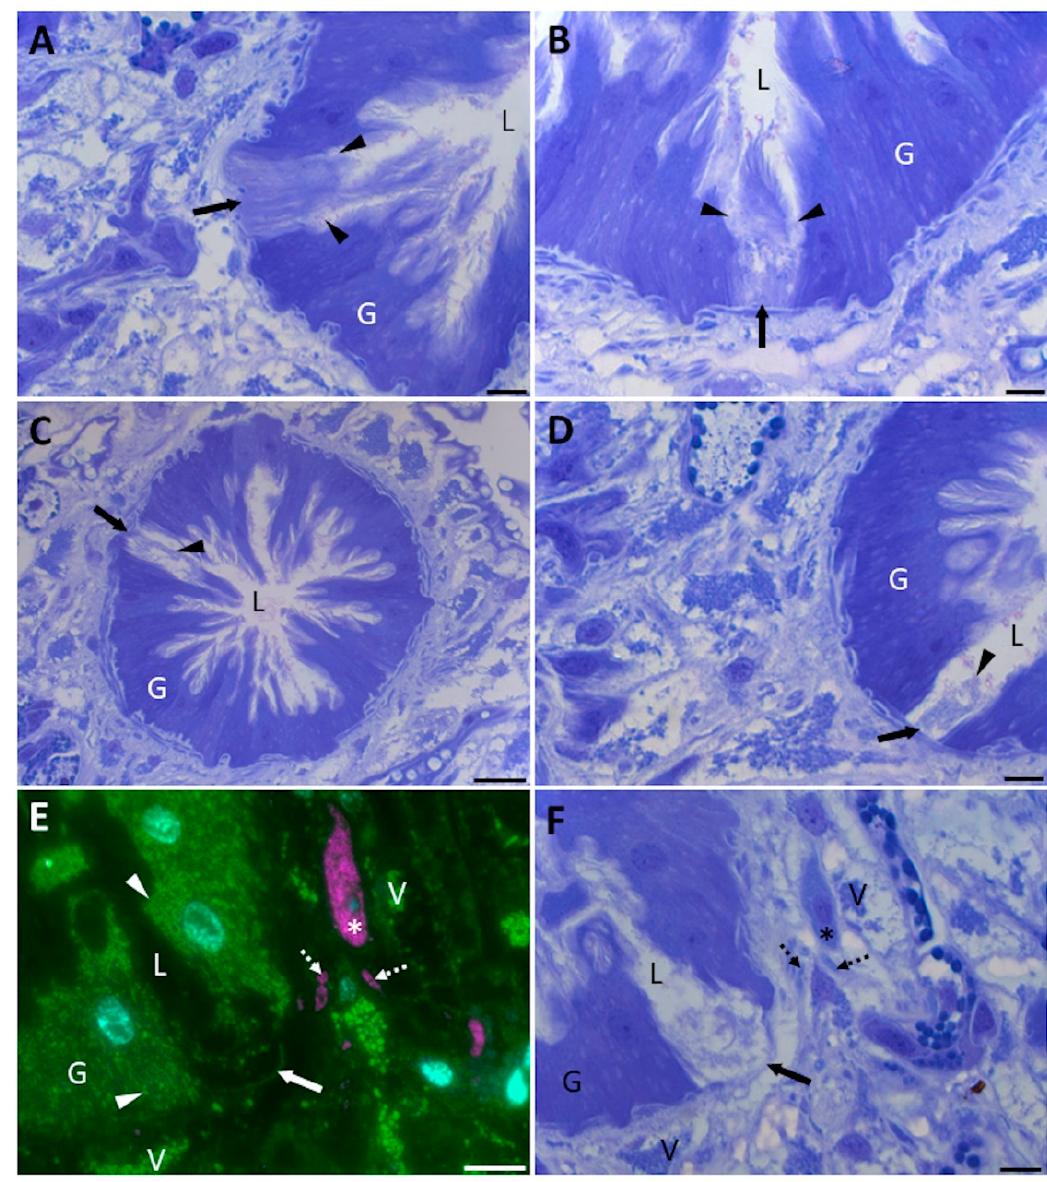
Figure 2. Individual gastrodermal cells of adult F. hepatica undergo progressive disintegration. ( A – D ) Toluidine blue staining showing gastrodermal cells at different stages of disintegration. Arrows point to the rupturing cells, and arrowheads indicate the disintegrating apical cell membrane ( A , B ) and residual material ( C , D ). ( E ) Immunostaining against FhRal-A (green) and tyrosinated α -tubulin (magenta) in the region proximal to a ruptured gastrodermal cell. Cell nuclei were counterstained with DAPI (cyan). Tyrosinated α -tubulin localises to vesicular structures in the parenchyma (dashed arrows) and packed within a specific cell (asterisk). FhRal-A localises to discrete puncta within gastrodermal cells which are concentrated at the cell apices (arrowheads), as well as groupings of vesicular structures (V) dispersedly packed within the sub-gastrodermal parenchyma. FhRal-A does not localise to the same cell labelled by the anti-tyrosinated α -tubulin antibody (asterisk). ( F ) Toluidine blue staining of the section shown in E shows that the structures positive for FhRal-A (V) stain dark blue (displaying basophilia), whilst those positive for tyrosinated α -tubulin (dashed arrows, asterisk) stain a lighter blue (displaying less basophilia). G, gut; L, lumen. Scale bars: 7.5 µ m ( A , B , D , E ), 25 µ m ( C , F ).